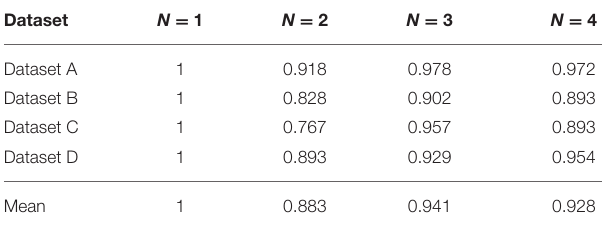
TABLE 4 | The effect of N-disease on efficiency.